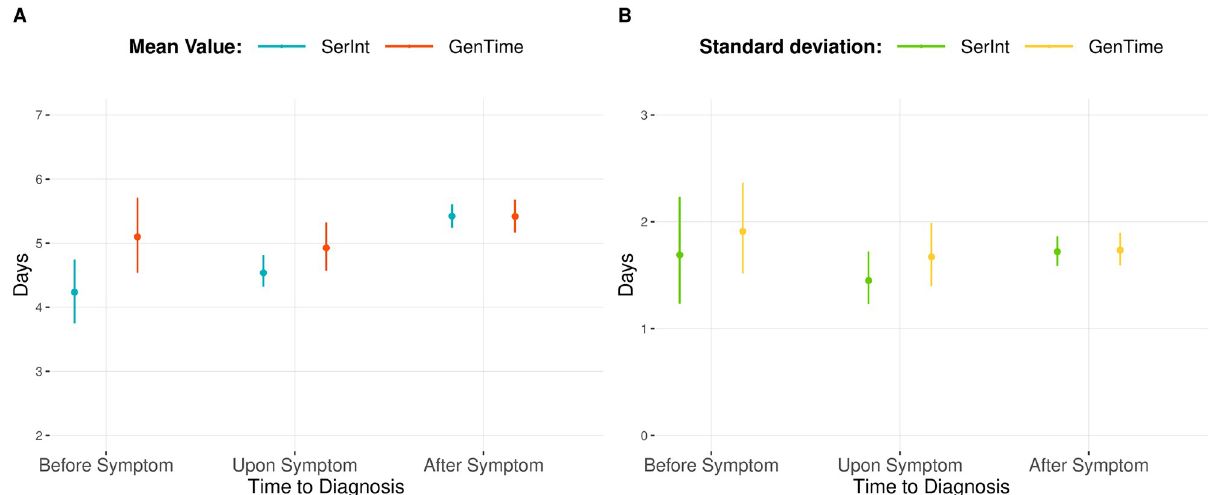
Fig 2. Control measure—Time to diagnosis. (A) Average and 95% confidence intervals for the mean realized serial and generation intervals and (B) associated realized standard deviations (B) for diagnosis before the onset of symptom (Before Symptom), coincident with symptom onset (Upon Symptoms) and gamma-distributed delays to diagnosis (Gamma